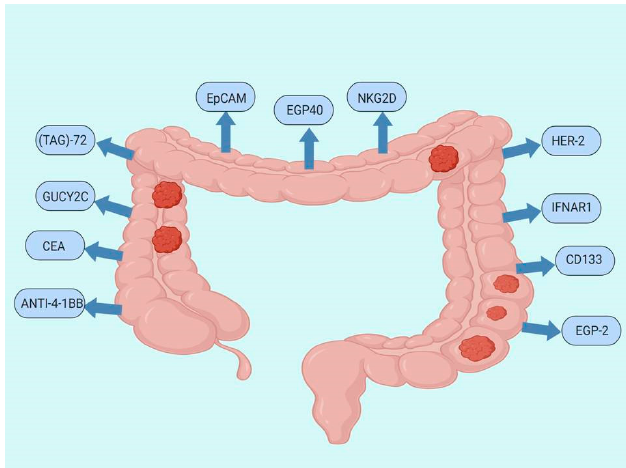
Figure 2. Targets for CAR T-cell therapy in CRC: Anti-4-1BB; CEA; guanylylcyclase2C (GUCY2C); TAG-72; EpCAM; epithelial glycoprotein 40(EGP40); NKG2D; HER-2; interferon alpha and beta receptor subunit 1(IFNAR1); prominin-1 (CD133); epithelial glycoprotein-2 (EGP-2).